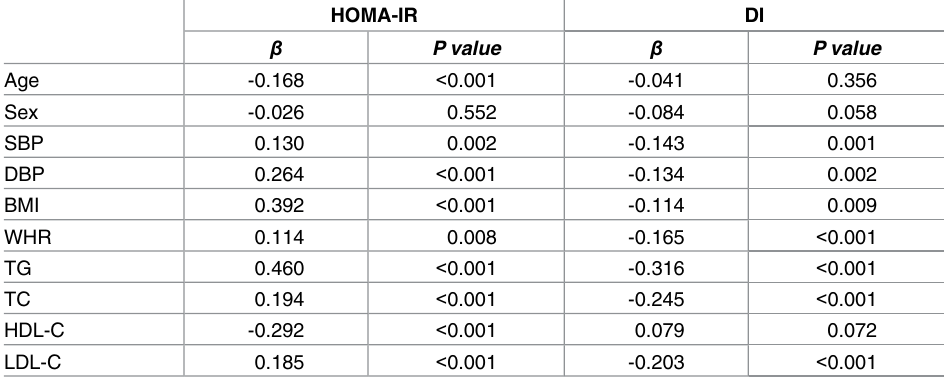
Table 2. Univariate correlation between HOMA-IR/DI and various parameters.